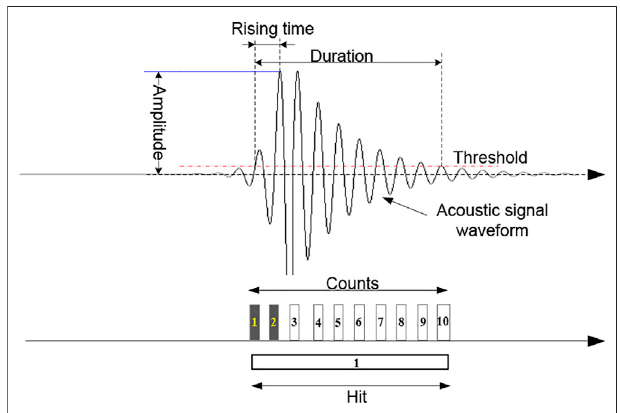
FIGURE 1 | Schematic diagram of conventional AE signal features (Ali et al.,